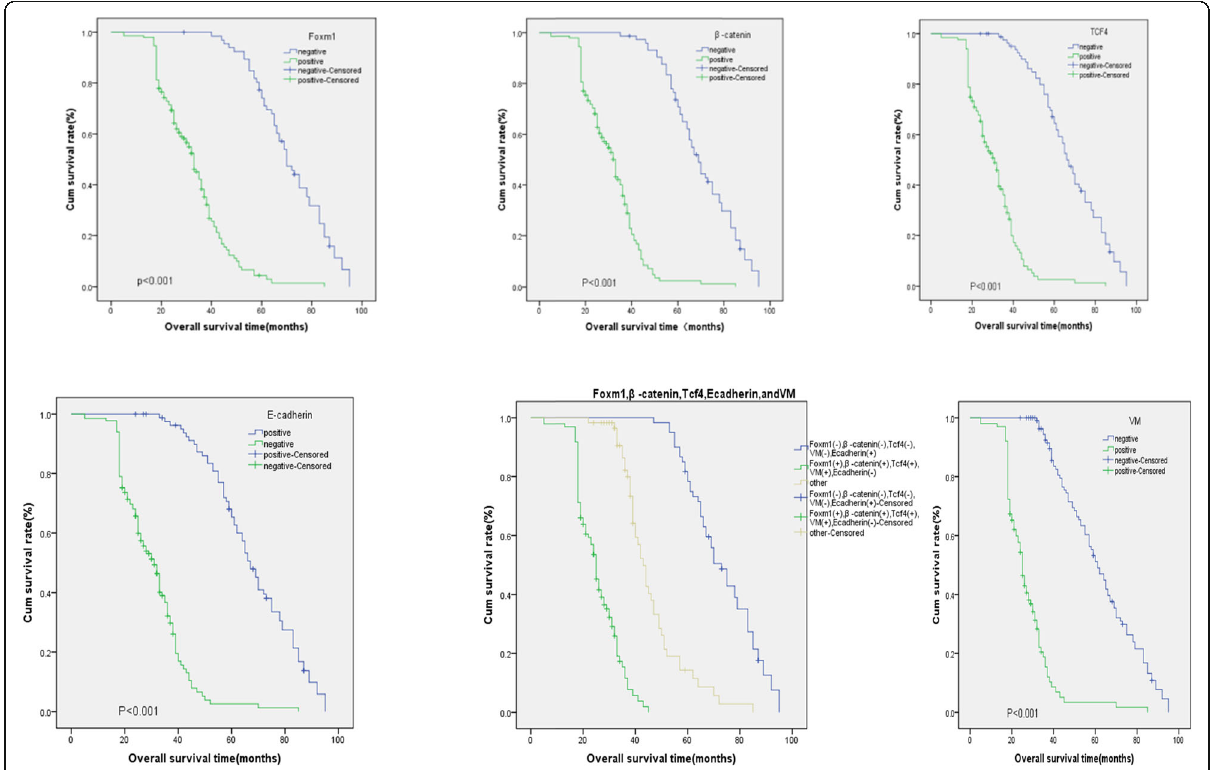
Fig. 3 Kaplan-Meier analysis of the survival rates of patients with ESCC. a Overall survival of patients in relation to FoxM1 expression (log-rank = 121.530, P < 0.001). b Overall survival of all patients in relation to β -catenin (log-rank = 132.879, P < 0.001). c Overall survival of patients in relation to TCF4 (log-rank = 129.901, P < 0.001), d Overall survival of patients in relation to VM expression (log-rank = 148.841, P < 0.001). e Overall survival of patients in relation to E-cadherin (log-rank = 69.208, P < 0.001). In ( a-e ), blue lines represents FoxM1 positive, or β -catenin, TCF4 or VM negative E-cadherin group; green lines: FoxM1 negative, or β -catenin, TCF4 or VM positive E-cadherin group. f Overall survival of all patients in relation to FoxM1, β -catenin, TCF4, VM and E-cadherin expression (log-rank = 220.469, P < 0.001). Blue lines: patients with negative E-cadherin and positive FoxM1, β -catenin, TCF4, VM expression; green line: patients with positive E-cadherin and negative FoxM1, β -catenin, TCF4, VM; brown line: other positive or negative